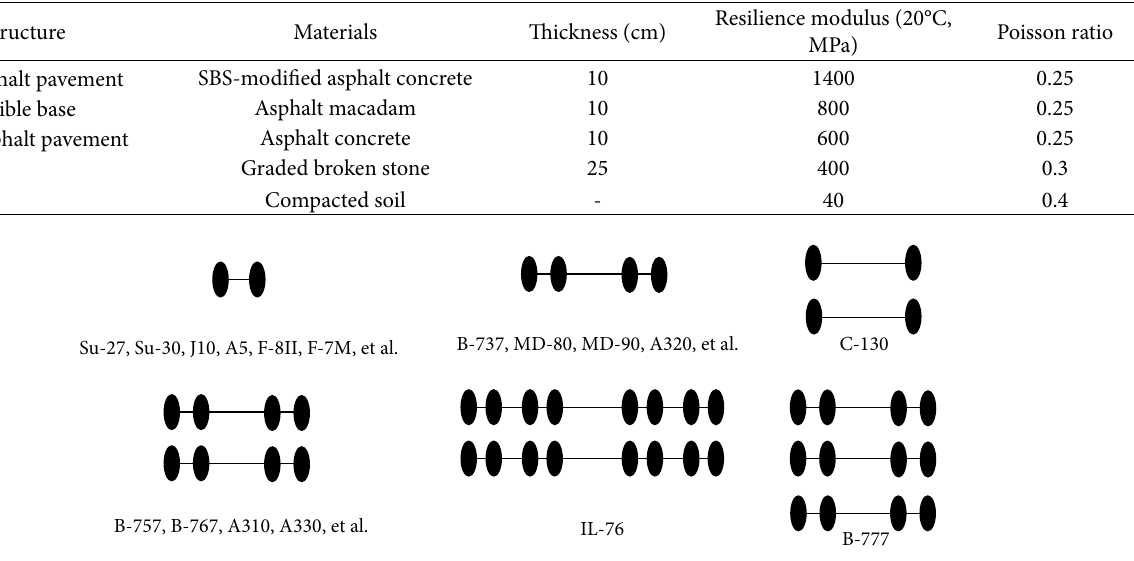
Table 1: Structural parameters of airport pavement.